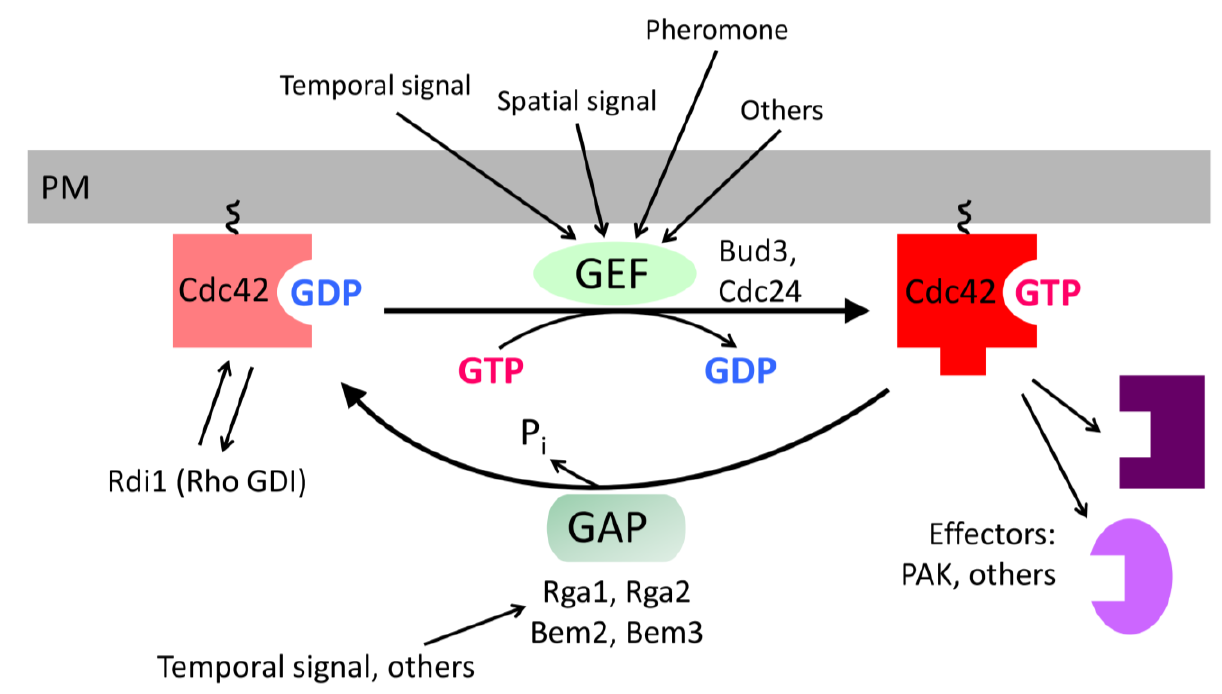
FIGURE 1: The Cdc42 GTPase and its regulators in budding yeast. Cdc42 activity is regulated by at least three types of regulators: the GEFs, Cdc24 and Bud3; the GAPs, Rga1, Rga2, Bem2, and Bem3; and the GDI Rdi1. These regulators are likely to mediate the regulation of Cdc42 in response to internal and external signals. Cdc42 regulates the organization of the actin and septin cytoskeletons and polarized secretion via its downstream effectors including